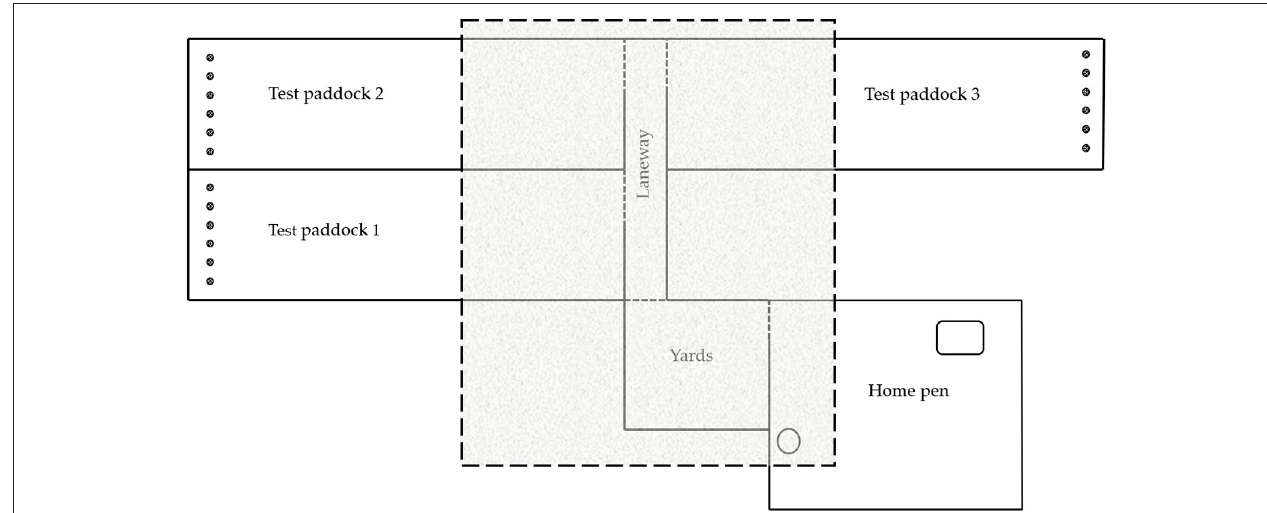
FIGURE 1 | Diagrammatic representation (not to scale) of the experimental site used in all three blocks, similarity seen in Colusso et al. (2020). The experimental design consisted of a mowed home pen where the animals were housed outside of training and testing. Each day of testing the cows were moved from the home pen to the yards, and a virtual fence (VF) was activated (shaded area). For testing, a treatment group was moved from the yards along the laneway and through the access gate into a test paddock. Test paddocks were randomly alternated across tests for each block. Test paddocks 100 × 20m contained lucerne cube feed in six buckets that were placed at the end of the paddock (60m from VF). The test paddocks were mowed to prevent grazing during testing. The VF was positioned 30m from the start of each test